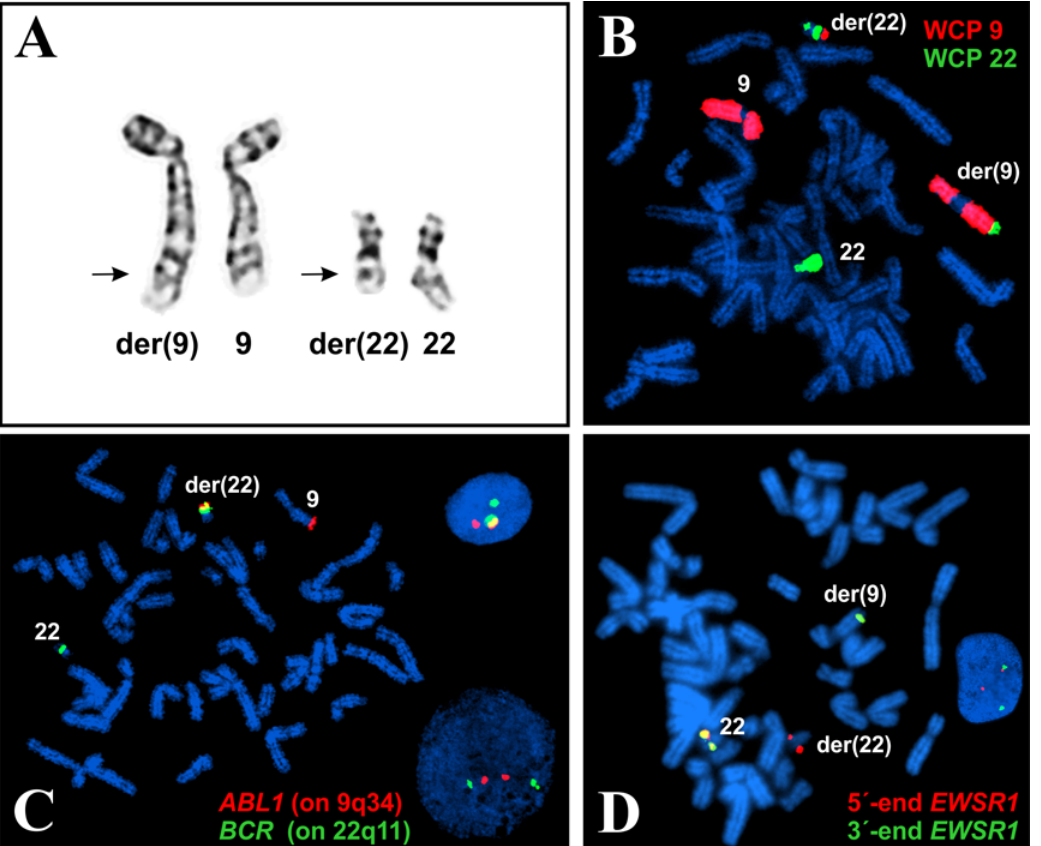
Fig 2. Cytogenetic and FISH data on the retroperitoneal leiomyoma. A) Partial karyotype showing the der(9)t(9;22)(q33;q12) and der(22)t(9;22)(q33;q12) with the corresponding normal chromosome homologs; breakpoint positions are indicated by arrows. B) FISH using whole chromosome painting probes for chromosome 9 (red signal) and 22 (green signal). C) FISH using the BCR/ABL(ABL1) Translocation Dual Fusion probe. D) FISH using the EWSR1 Breakapart probe.